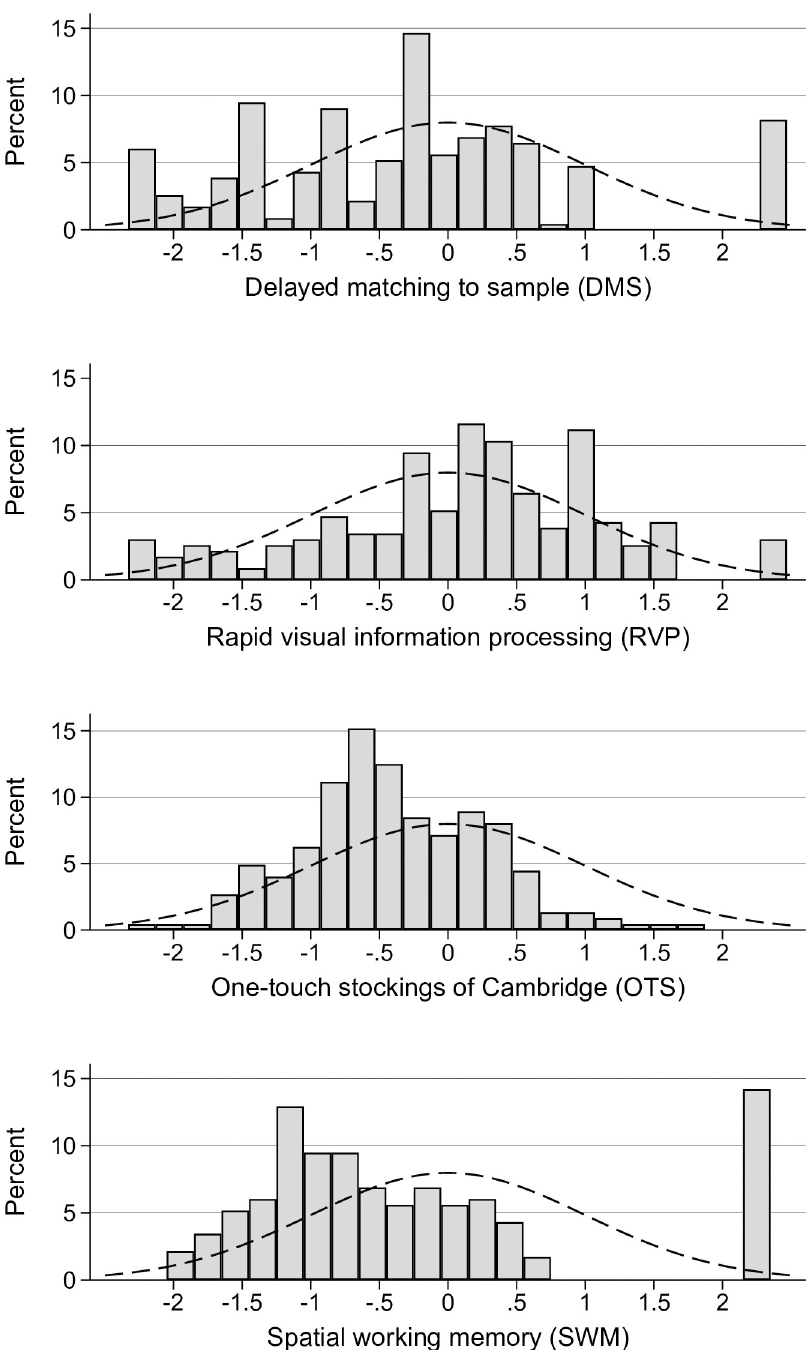
Fig 2. Distribution of z-scores for CANTAB cognitive tests, with standard normal curve representing the norm population.